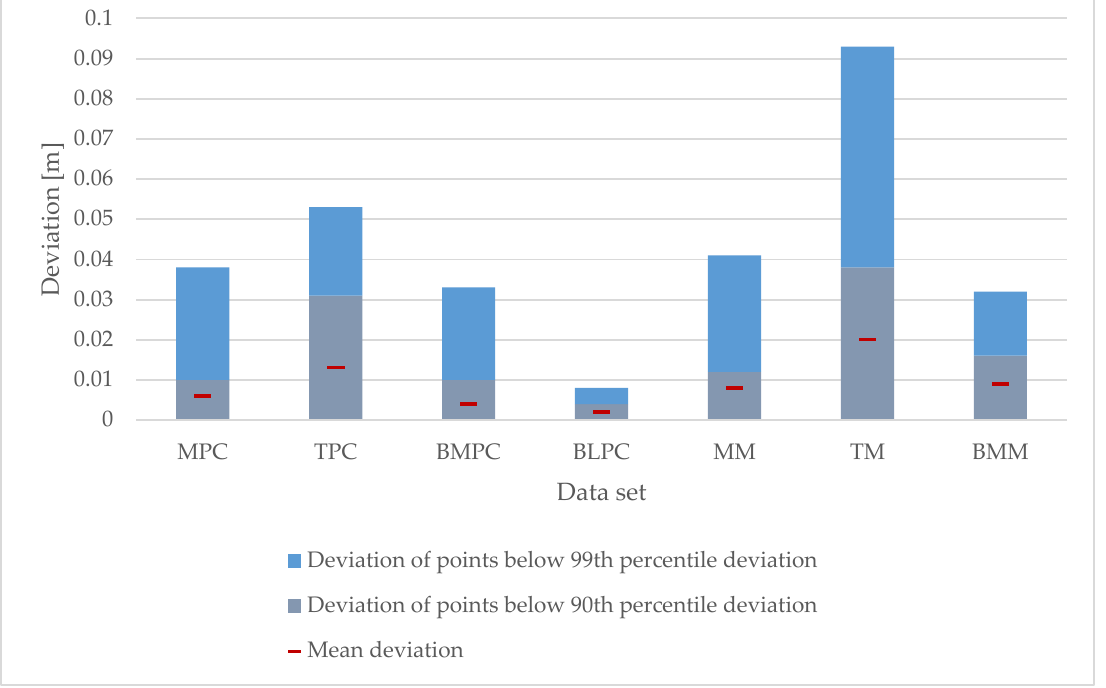
Figure 6. The deviations of the points within the 90th and 99th percentile deviations for the hall 101 room geometry, with mean deviations noted.